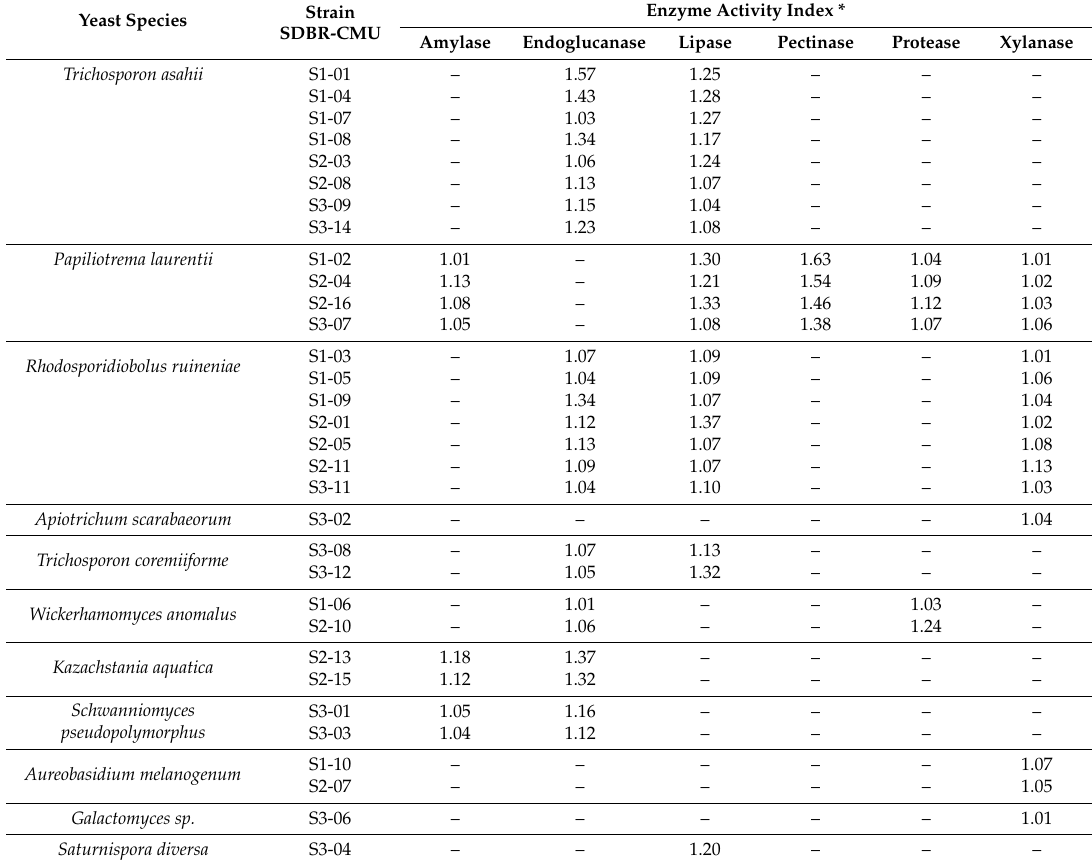
Table 5. Enzyme production of yeast strains in this study.